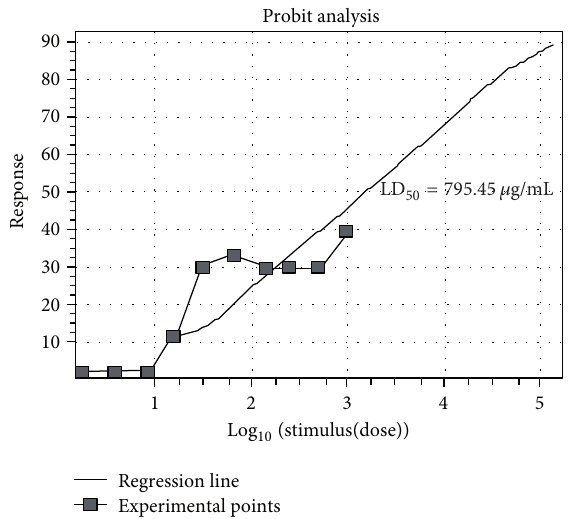
pointsLog Regression line Experimental F 1: Brine shrimp lethality bioassay-probit analysis of ENO. Different concentrations of ENO (1–1000 g/mL) was tested against brine shrimp for